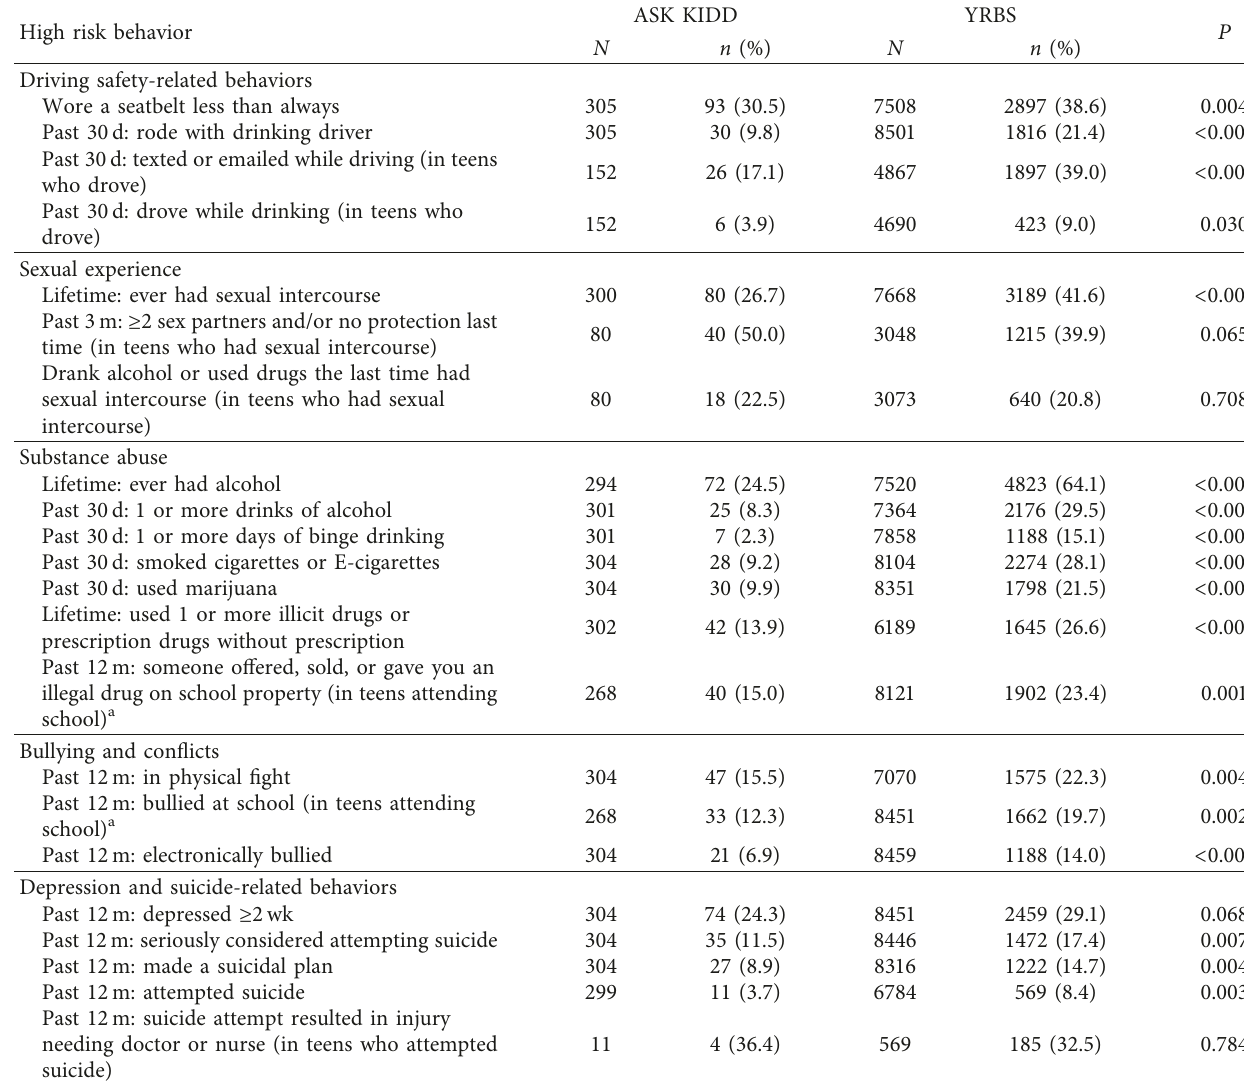
Table 2: Comparisons of risk behaviors between adolescents with CKD (ASK KIDD) and 2015 YRBS National Data. High risk